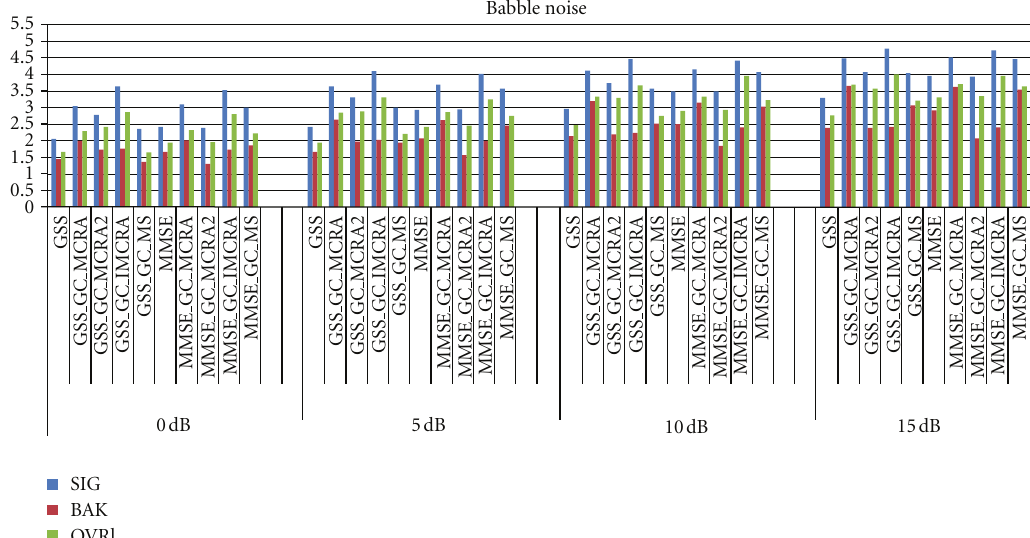
Figure 7: SIG-BAK-OVRL scores for proposed speech enhancement with the gammachirp decomposition compared to the GSS and the MMSE at di ff erent SNR input for babble